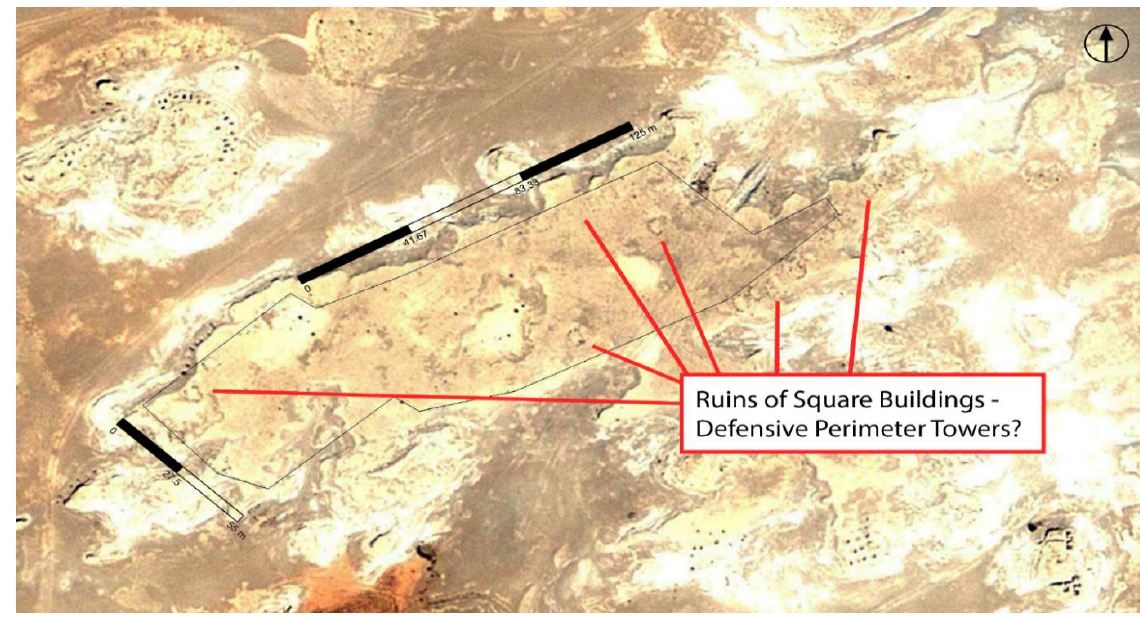
Figure 10: Remains on an approx. 3-4 m high plateau. Ruins of square towers on a detention wall. Looking from the South. (Google 2010)